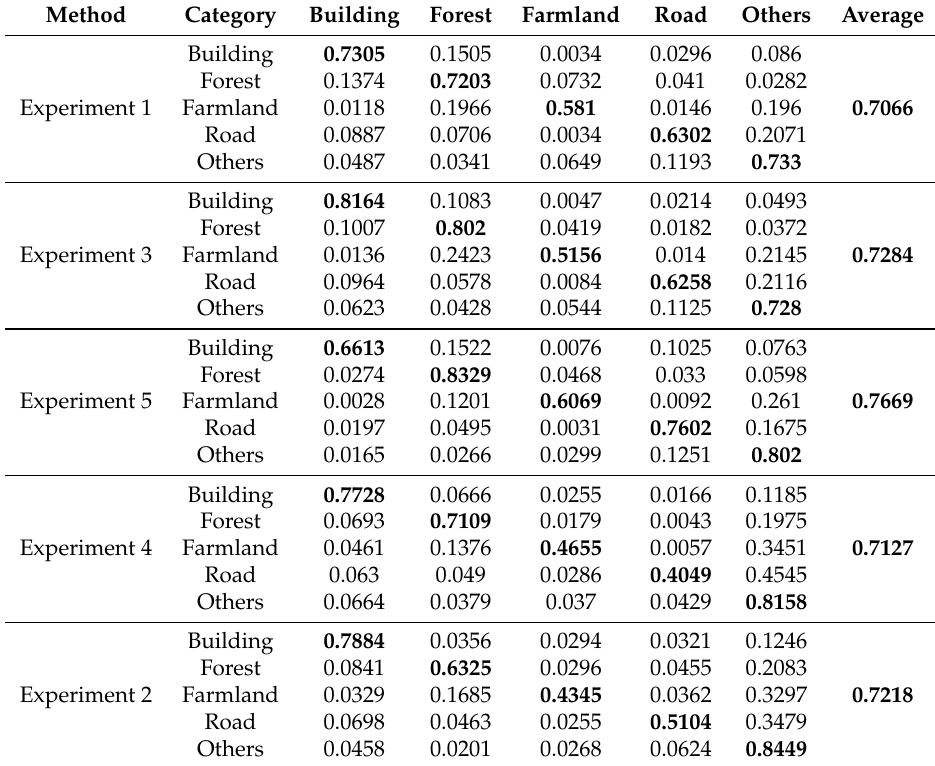
Table 3. Confusion matrix for the classification results of ESAR data.